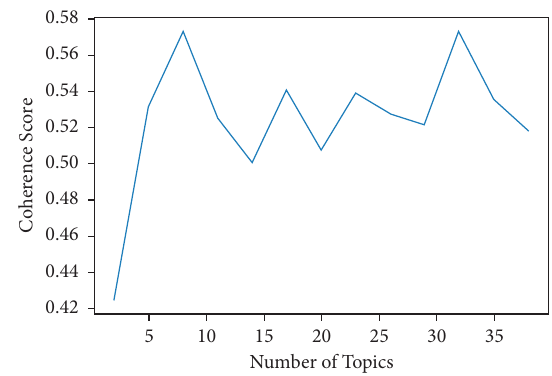
Figure 1: Value of Cv coherence in different numbers of